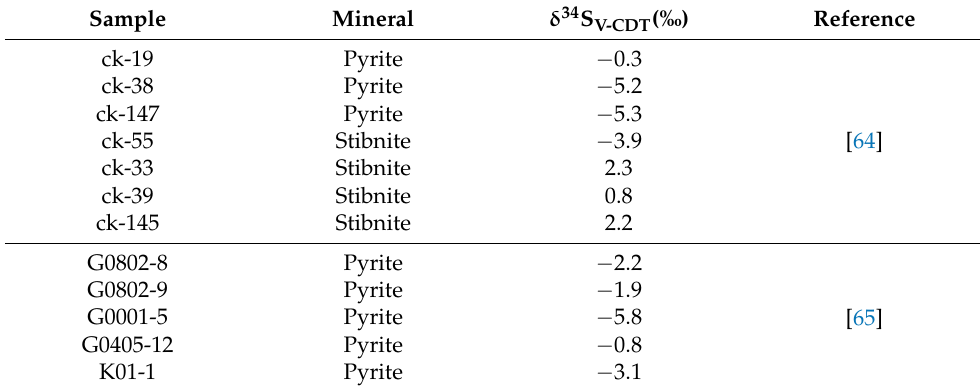
Table 3. S isotope data of the sulfides from the gold